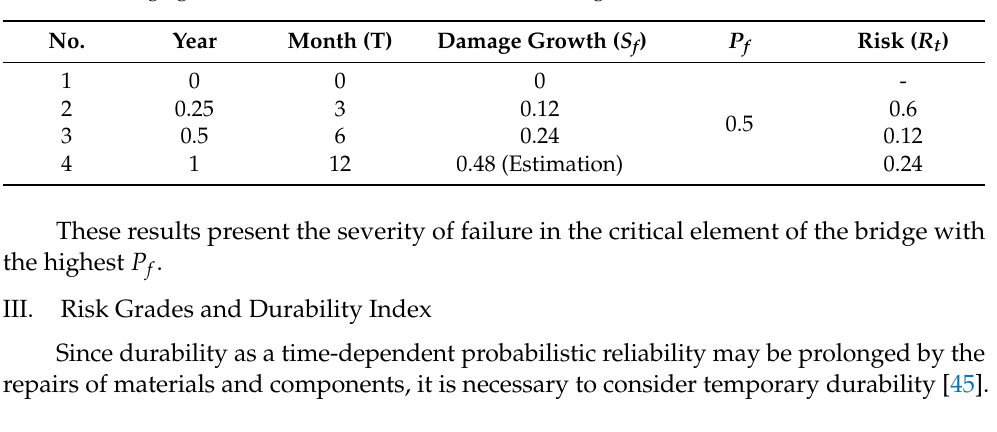
Table 4. Damage growth in the abutment of the critical bridge